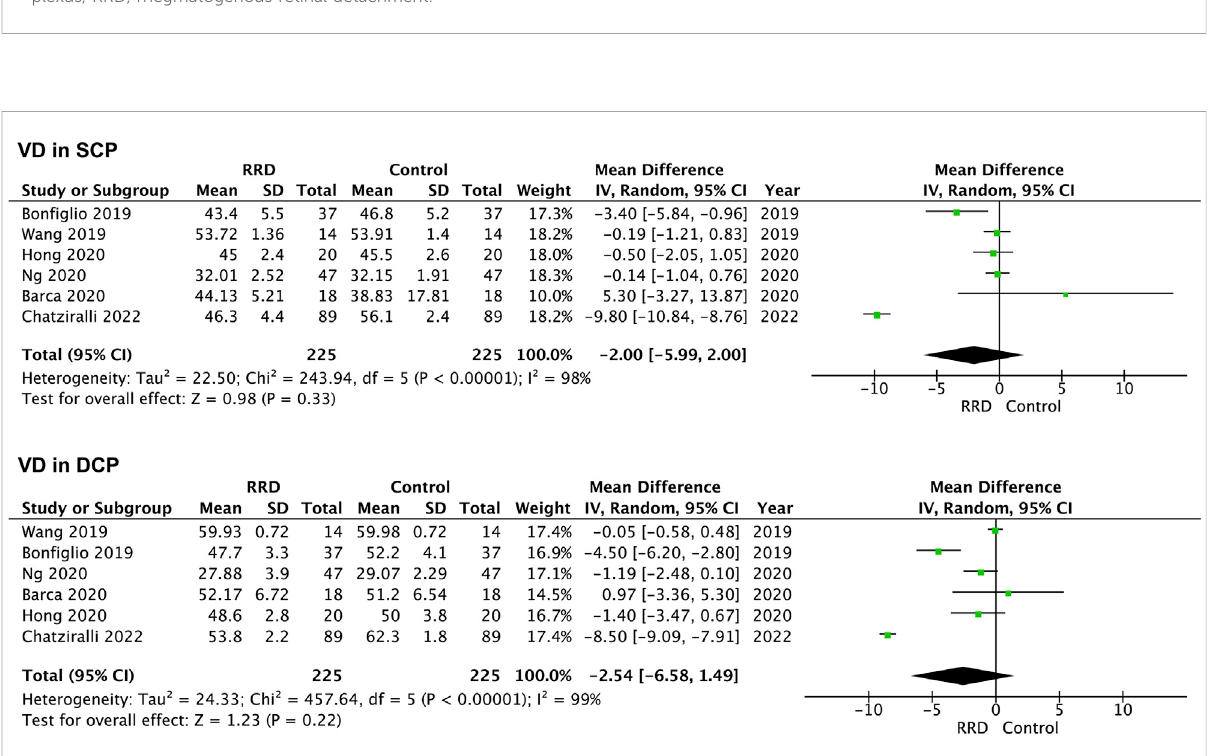
FIGURE 7 ForestplotsofchangesinparafovealVDineyeswithMacula-offRRD.VD,vasculardensity,SCP,super fi cialcapillary plexus;DCP,deepcapillary plexus, RRD, rhegmatogenous retinal